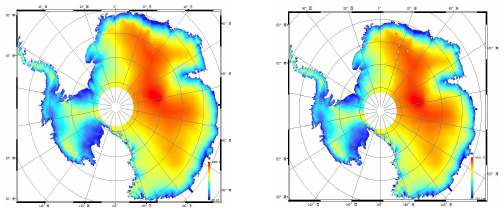
Figure 1. DEM over the cycle in Antarctica